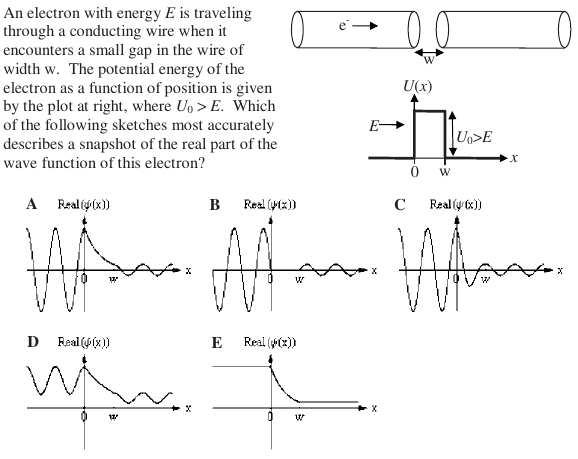
FIG. 6. A tunneling question from an early version of the QMCS. This question was developed to test students understanding of tunneling wave functions. It has been removed from the QMCS because interviews suggest that it tests memorization rather than conceptual